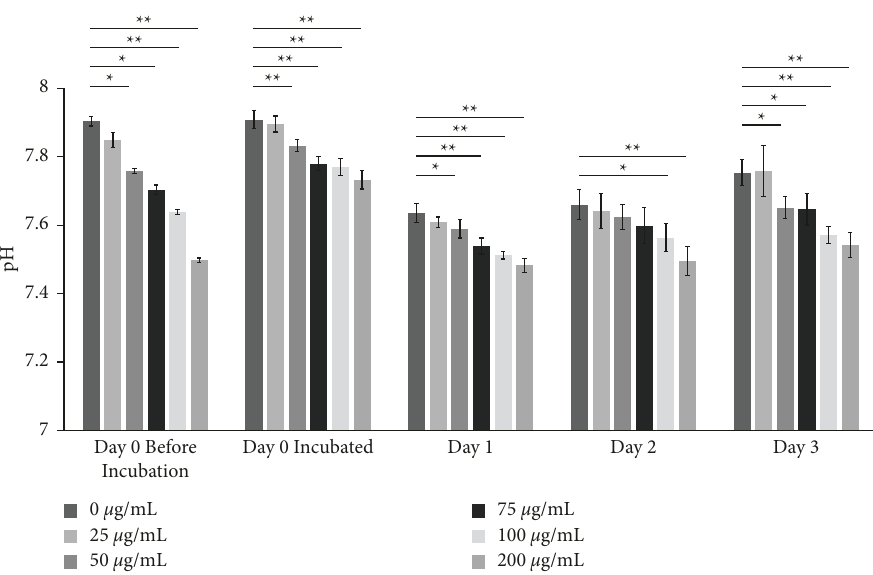
Figure 2: Acetylsalicylic acid (ASA) 3-day pH evaluation showed that the pH of the ASA-treated culture medium was within the biological range for the human dental pulp cells (HDPCs) culture. n